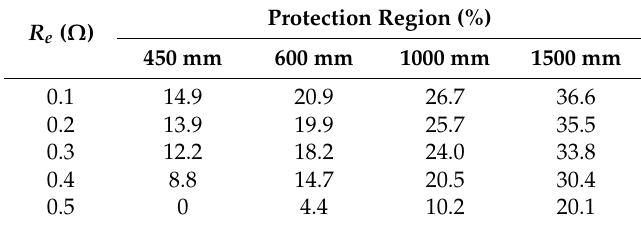
Table 3. Influence of electrode resistance on protection region of arcing horns.